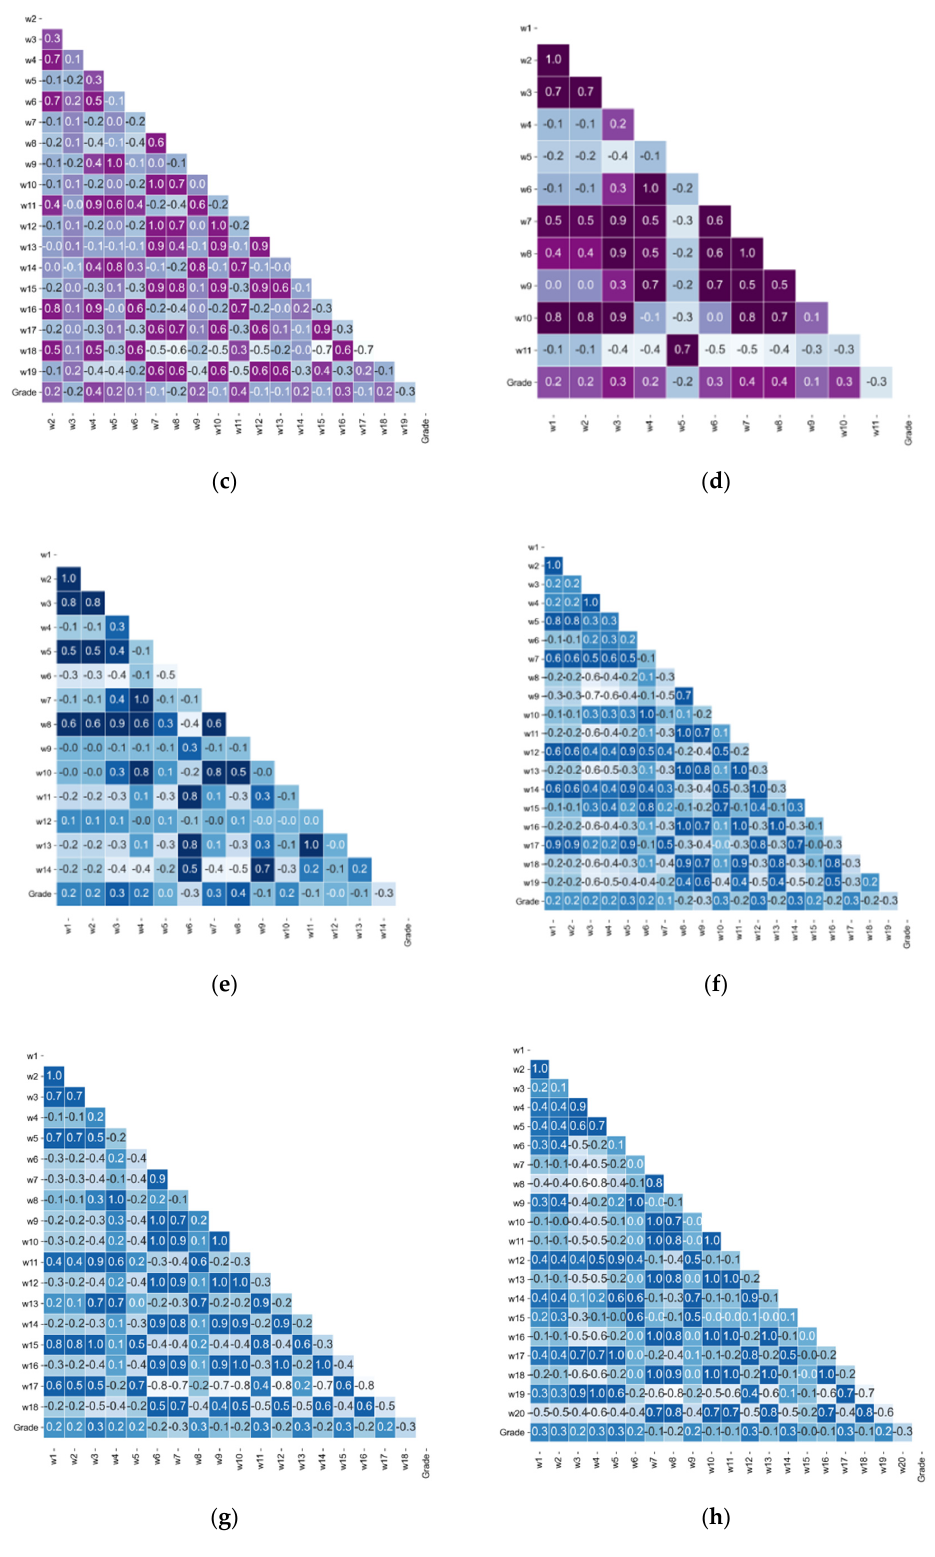
Figure 4. Correlation matrices of wavelet filters: ( a ) HHH, ( b ) HHL, ( c ) HLH, ( d ) HLL, ( e ) LHH, ( f ) LHL, ( g ) LLH, ( h ) LLL.